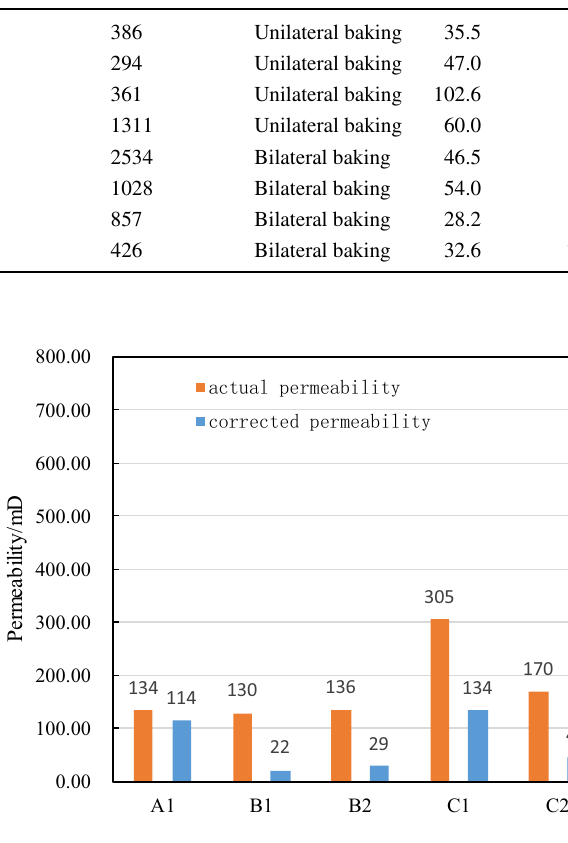
Table 2 the first batch development wells information in well blocks A, B and C of Bohai X Oilfield Well area